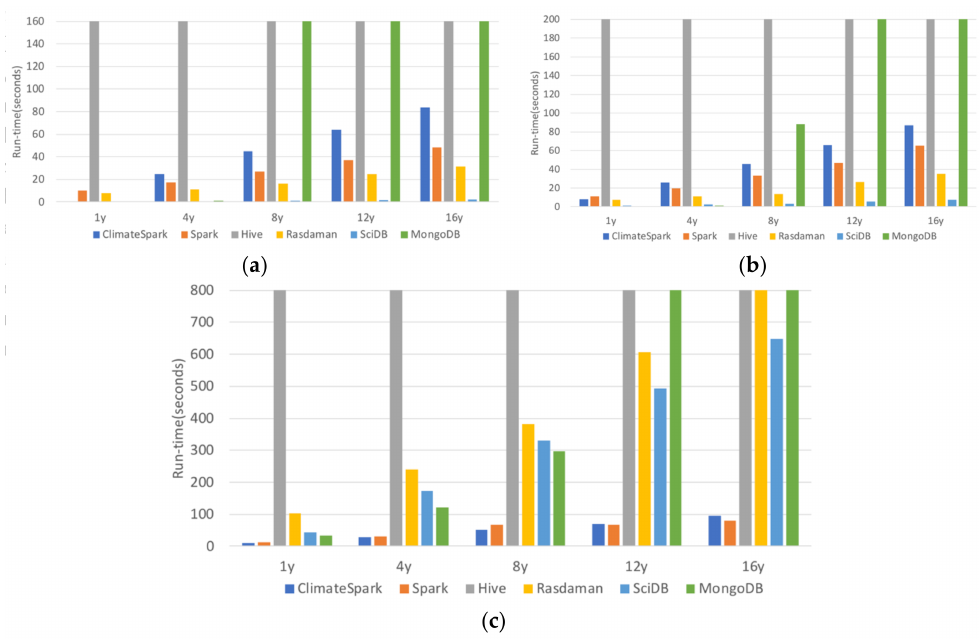
Figure 9. The spatiotemporal query for the 5D variable at: ( a ) the point (Boulder) time series query by varying the time range; ( b ) the area average for the Colorado State by varying the time rang; and ( c ) the global average by varying the time